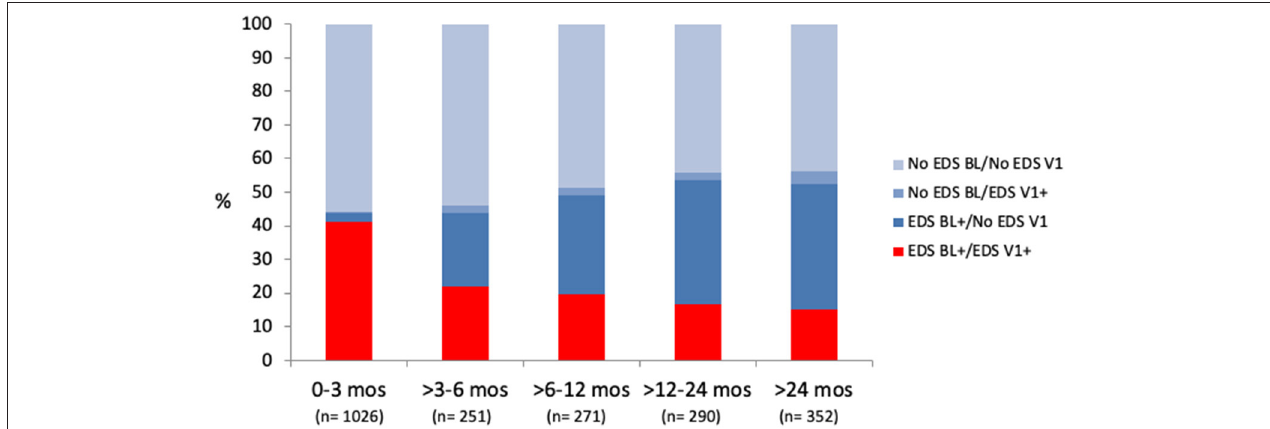
FIGURE 5 | Distribution of four groups, stratified based on occurrence of EDS at baseline (BL) and follow-up (V1), according to time of first follow-up visit. Persistent EDS at follow-up (in red) was more frequent in patients seen during first 3 months of CPAP treatment ( p < 0.0001 by X 2 , p for trend < 0.0001). No EDS BL/No EDS